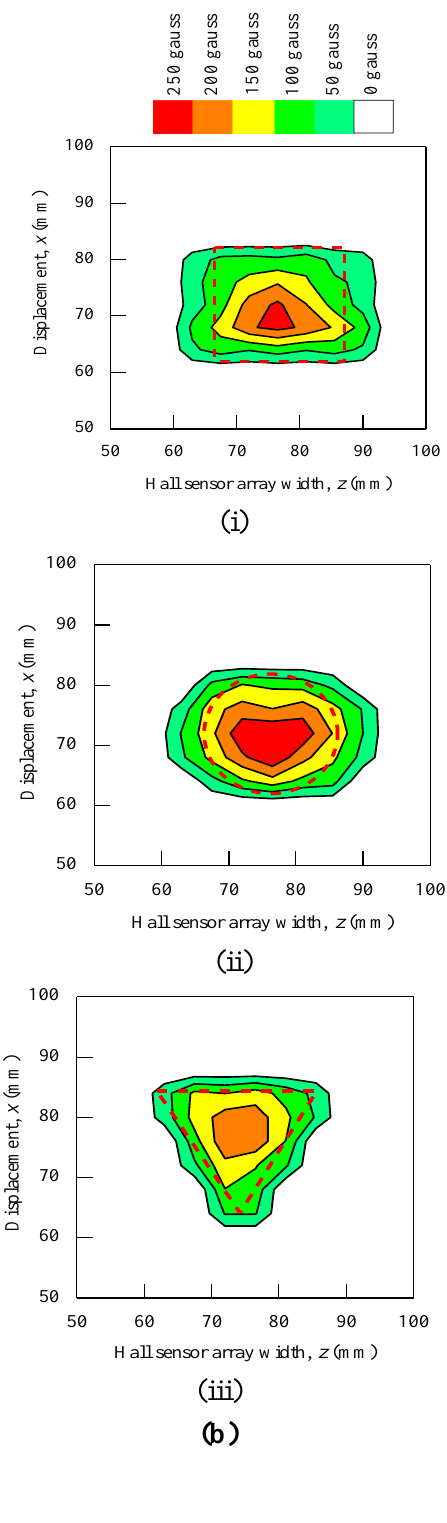
Figure 9. Magnetic imaging for square, round and triangular specimen shapes. ( a ) Induced Hall Voltage value distribution; ( b ) Absolute value of the flux density